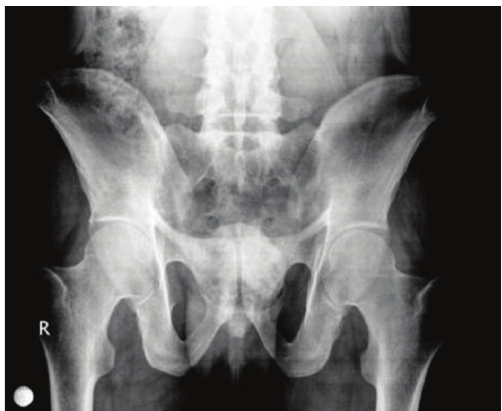
Figure 1: Sacroiliac joint graphy showed bilateral chronic sacroili- itis.